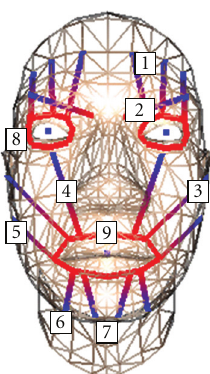
Figure 7: The major human facial muscles: (1) occipitofrontalis, (2) corrugator, (3) zygomaticus major, (4) levator, (5) buccinator, (6) depressor, (7) mentalis, (8) orbicularis oculi, and (9) orbicularis oris.